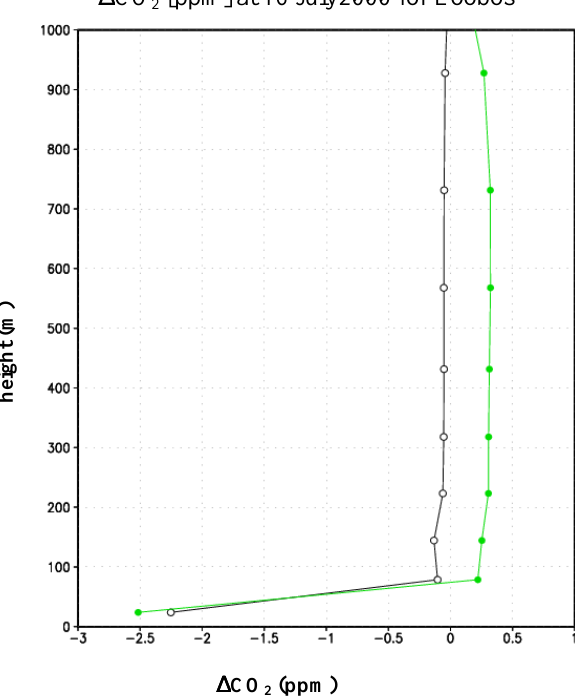
Fig. 17. Vertical profile at Loobos (16 July 2002, 00:00GMT) of the difference in simulated [CO 2 ] (ppm) between control simulation and a 20% increased anthropogenic emissions simulation (black) and between the control simulation and 20% increased biogenic fluxes simulation